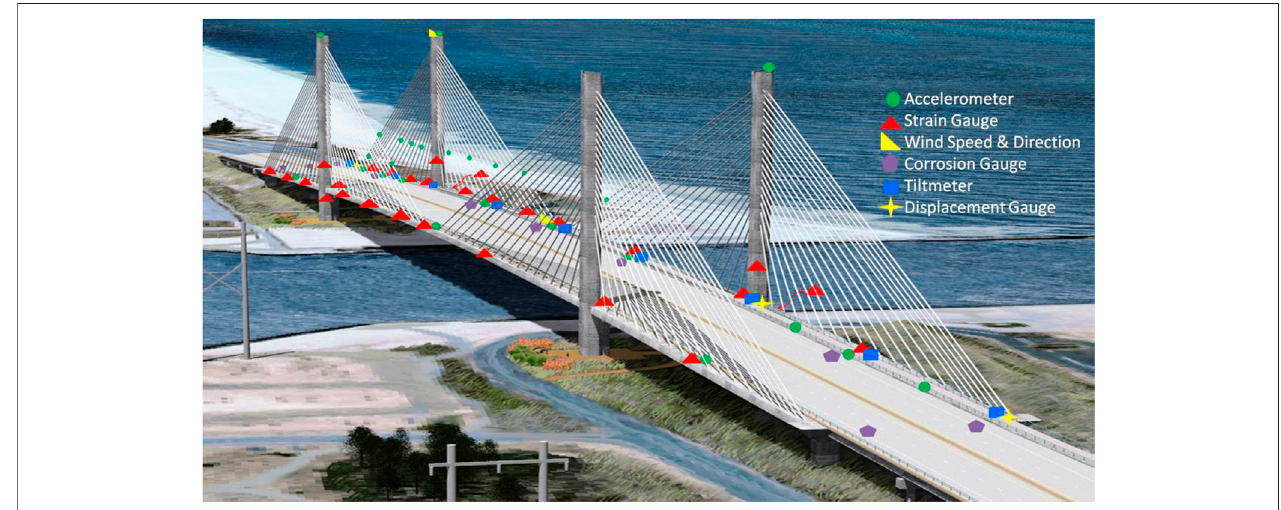
FIGURE 2 | Layout of sensors in the SHM system (Shenton et al., 2017).